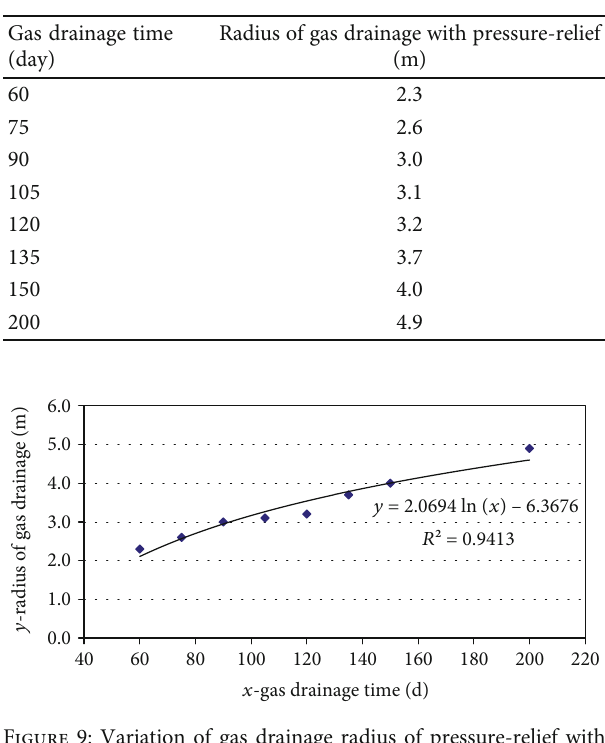
Figure 9: Variation of gas drainage radius of pressure-relief with